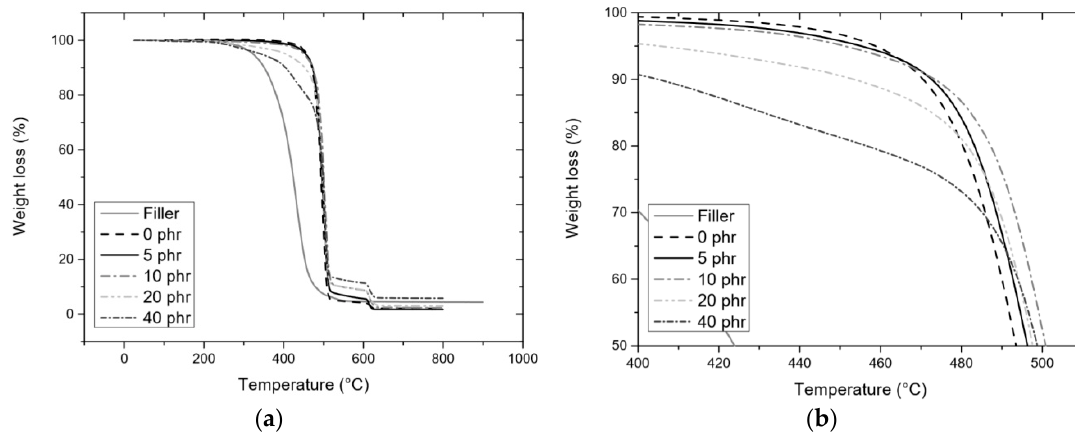
Figure 7. Thermal Gravimetric Analysis (TGA) curves of POSS-A filler and F TA nanocomposites at different filler loading under nitrogen. ( a ) unzoomed; ( b ) zoomed.